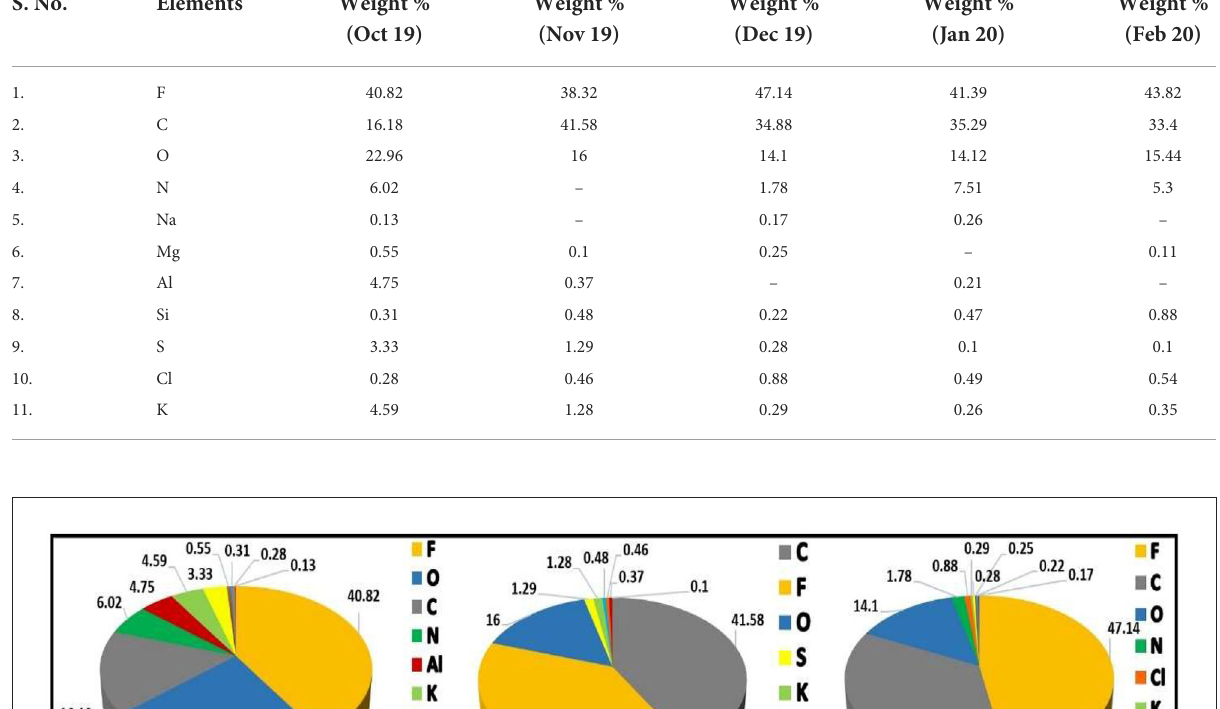
TABLE 2 Weight % ( ± standard deviation) of the elements quantified in the PM 2.5 sample during the study period. S.